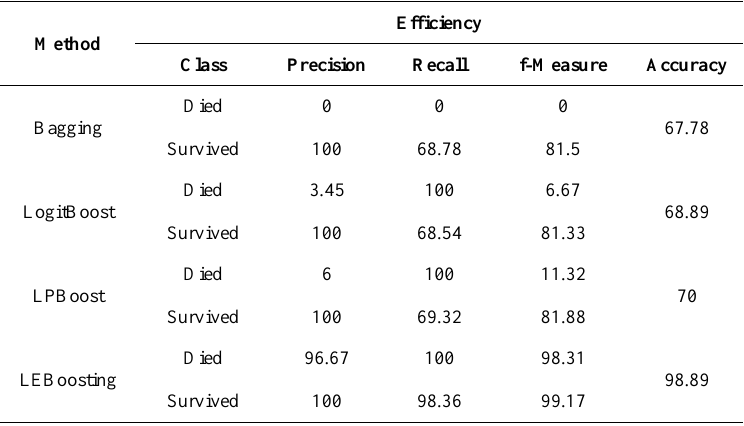
Table 5. Performance Comparison with other Ensemble